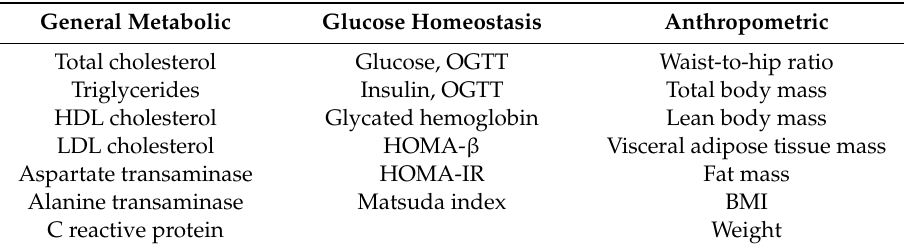
Table 1. Measurements gathered in this study divided into general metabolic, glucose homeostasis, and anthropometric parameter categories. Glucose and insulin concentrations were measured at 4 time points during the oral glucose tolerance test (0, 30, 60, and 120 min) and then used to calculate their area-under-the-curves. Principal components analysis was performed for variables found within these variable groups. HDL cholesterol, high-density lipoprotein cholesterol; LDL cholesterol,